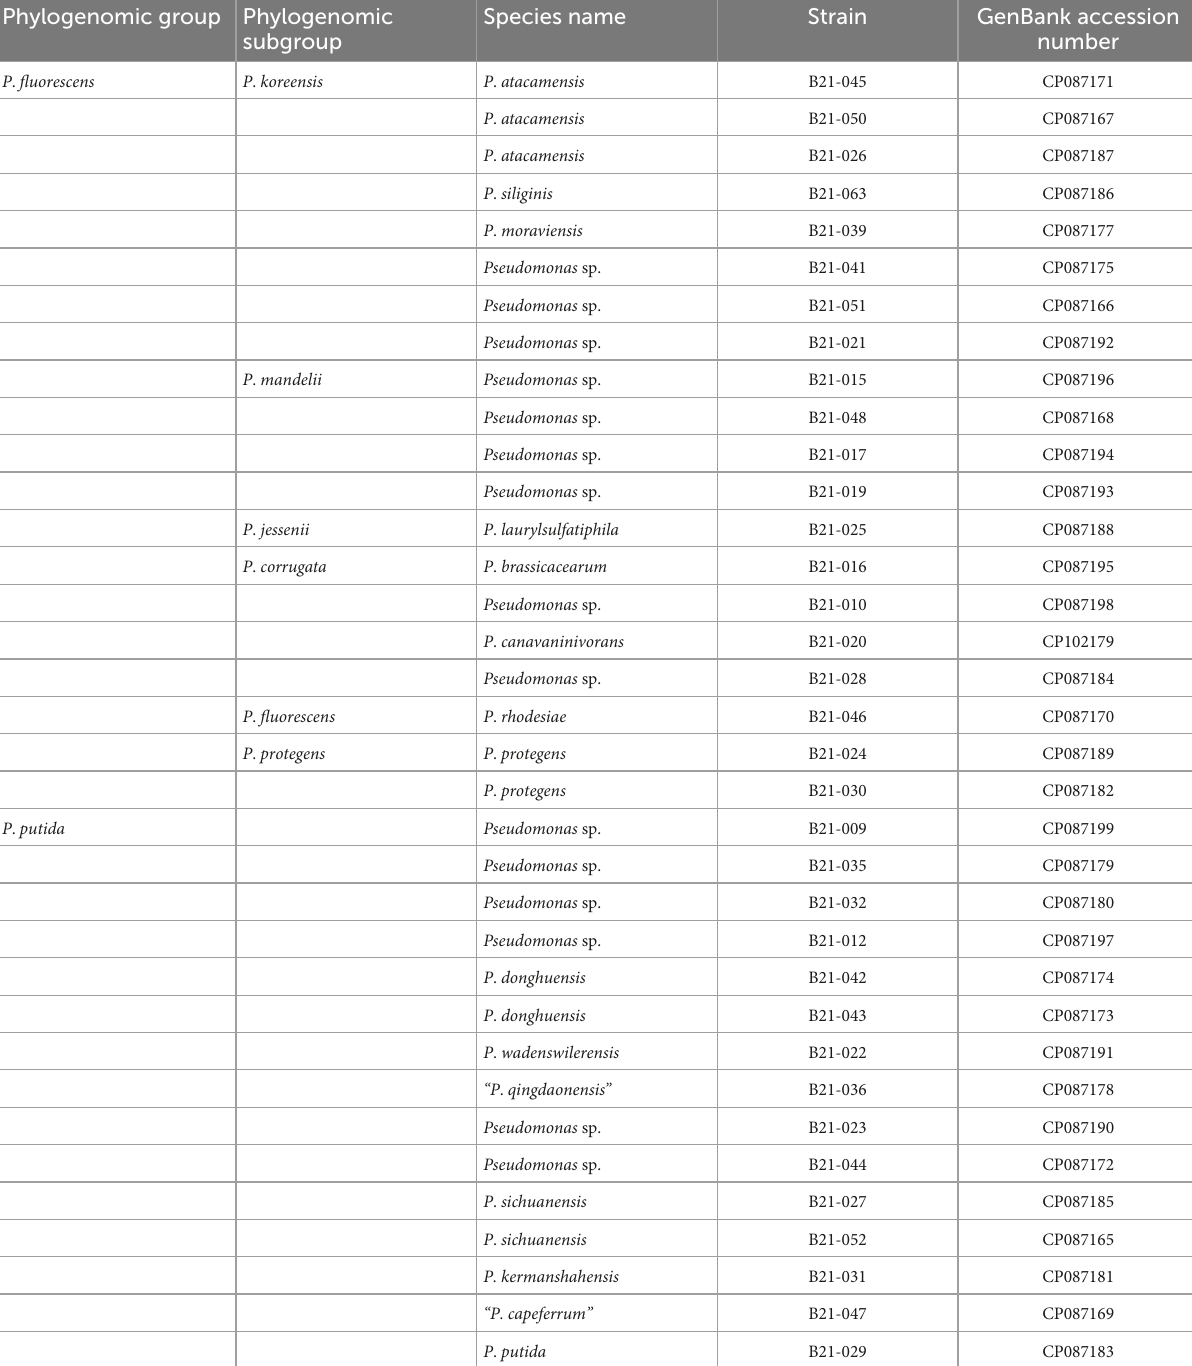
TABLE 1 List of the 35 sequenced Pseudomonas strains used in this study, according to their phylogenomic groups and